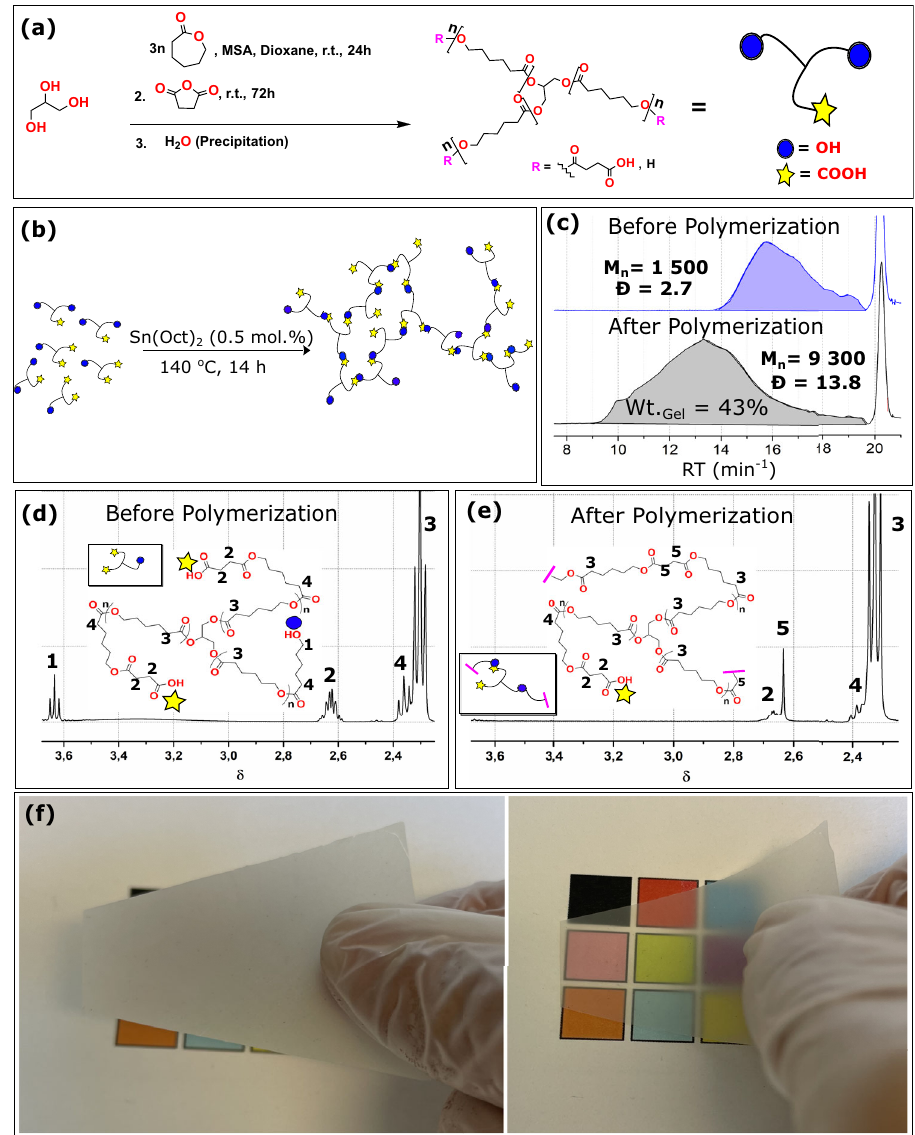
Fig. 2 | Insights into the procedures of the polyester oligomer formation and polymerization into polymeric fi lm. a Synthesis of functional caprolactone oli- gomers. b Schematic representation of the oligomer polymerization system cata- lyzed by Sn(Oct) 2 . c Number average molecular weight (M n ) and dispersity index ( Đ )of the oligomers before and after polyesteri fi cation, the measurement is per- formed on the extracted, soluble polymer fraction. d 1 H NMR on the starting